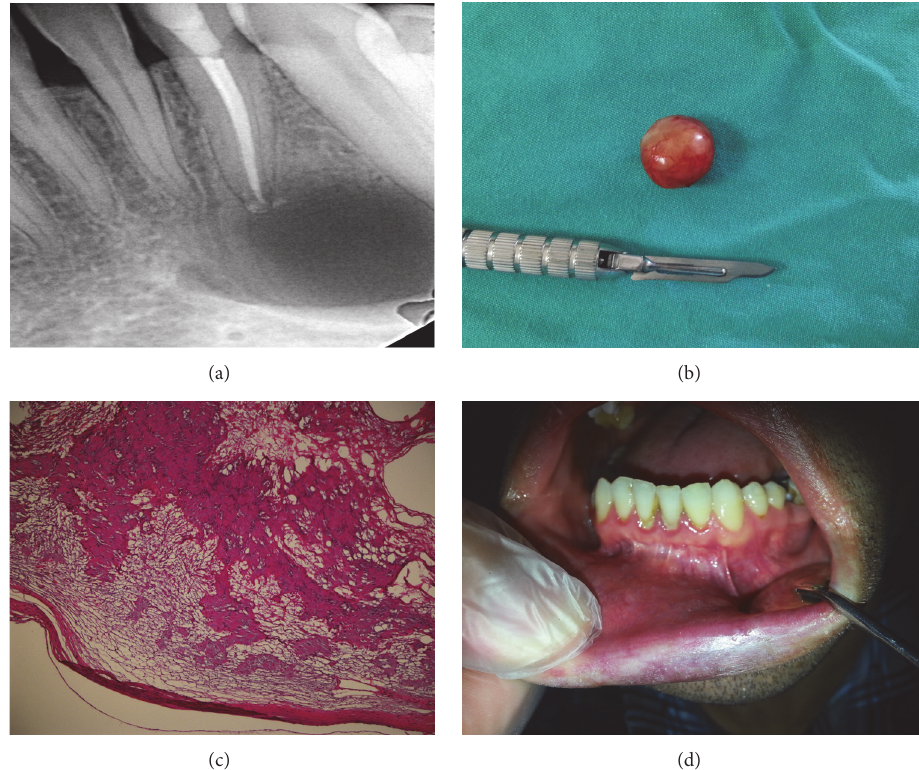
Figure 2: Images of the second case: (a) periapical radiographic image of the mandibular cavity that occurred secondary to schwannoma, (b) enucleated material, (c) fusiform mesenchymal cells forming cellular (Antoni type A) and loose (Antoni type B) areas (40x magnification), and (d) oral cavity at the postoperative 1st